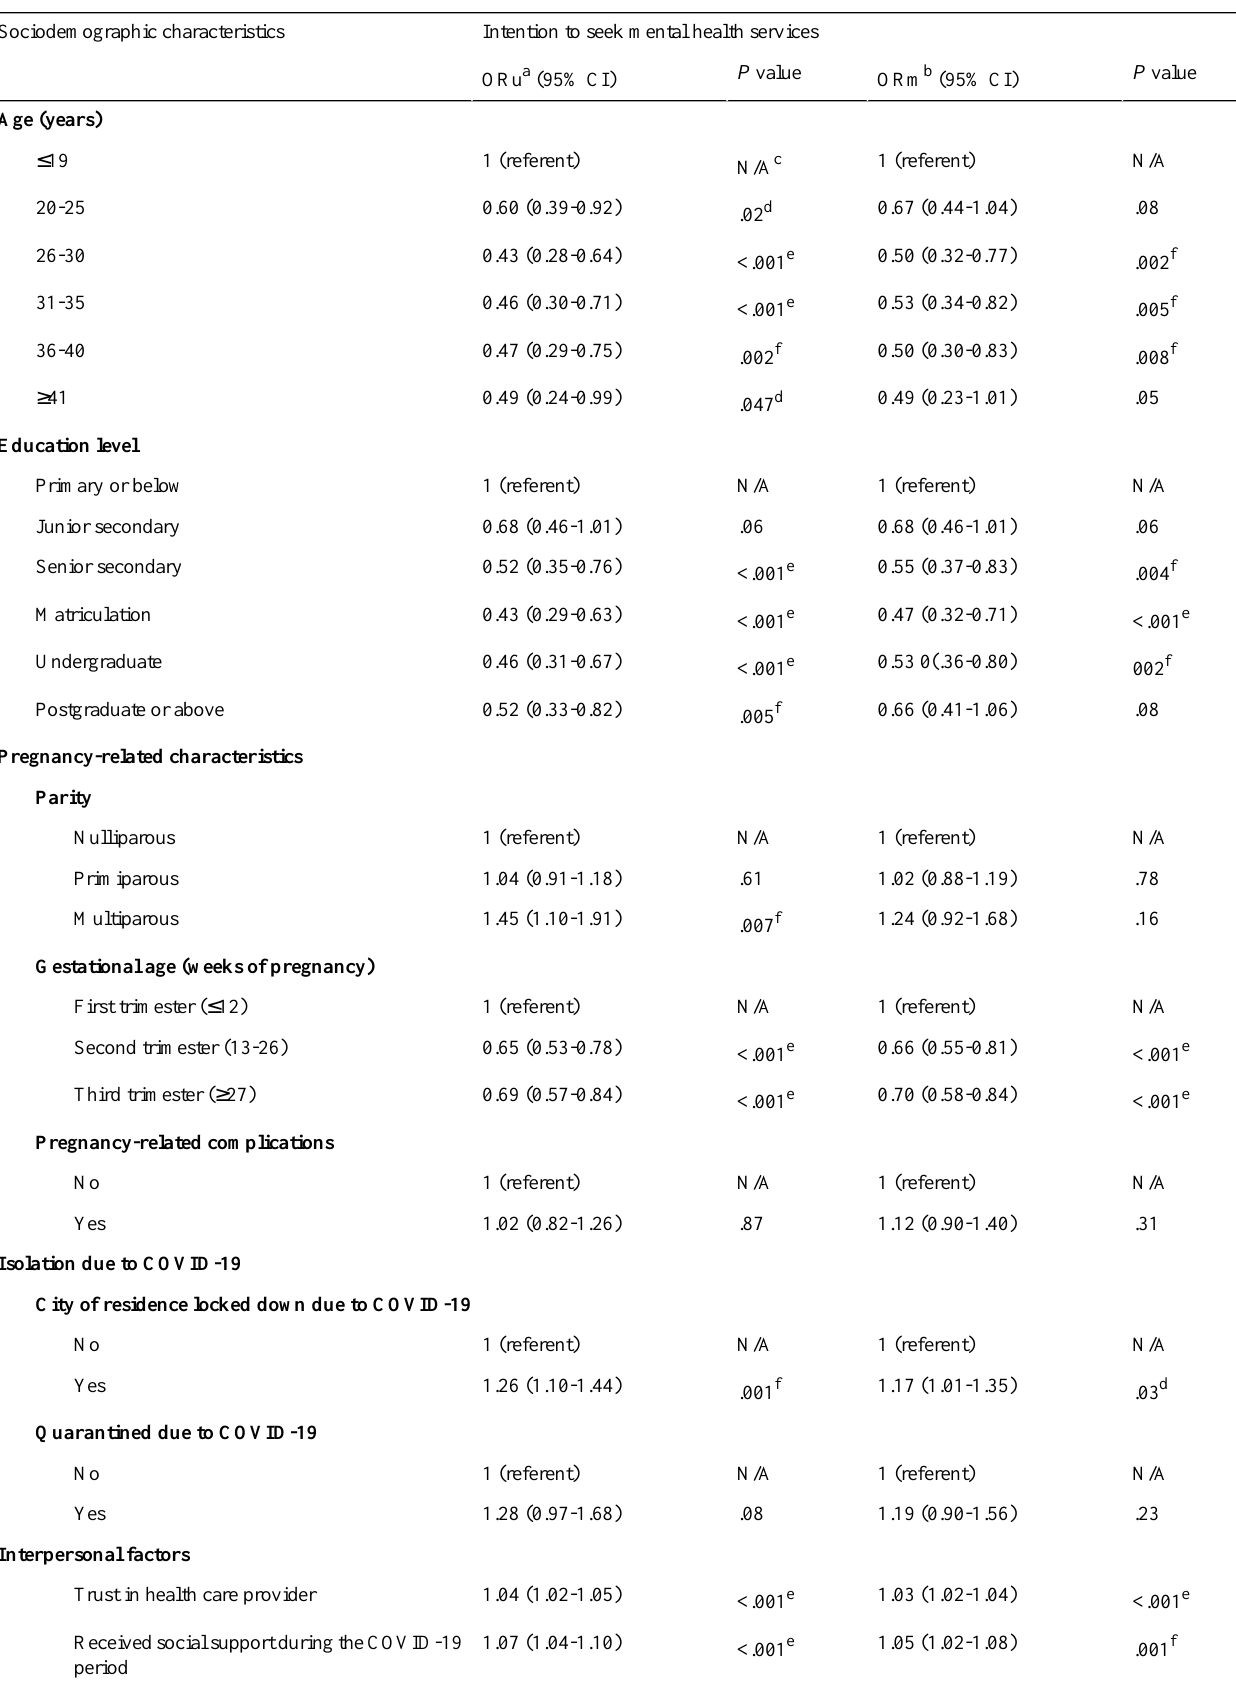
Table 2. Logistic regression analysis of intentions to seek mental health services among pregnant women with probable depression and anxiety (N=6248). Intention to seek mental health servicesSociodemographic